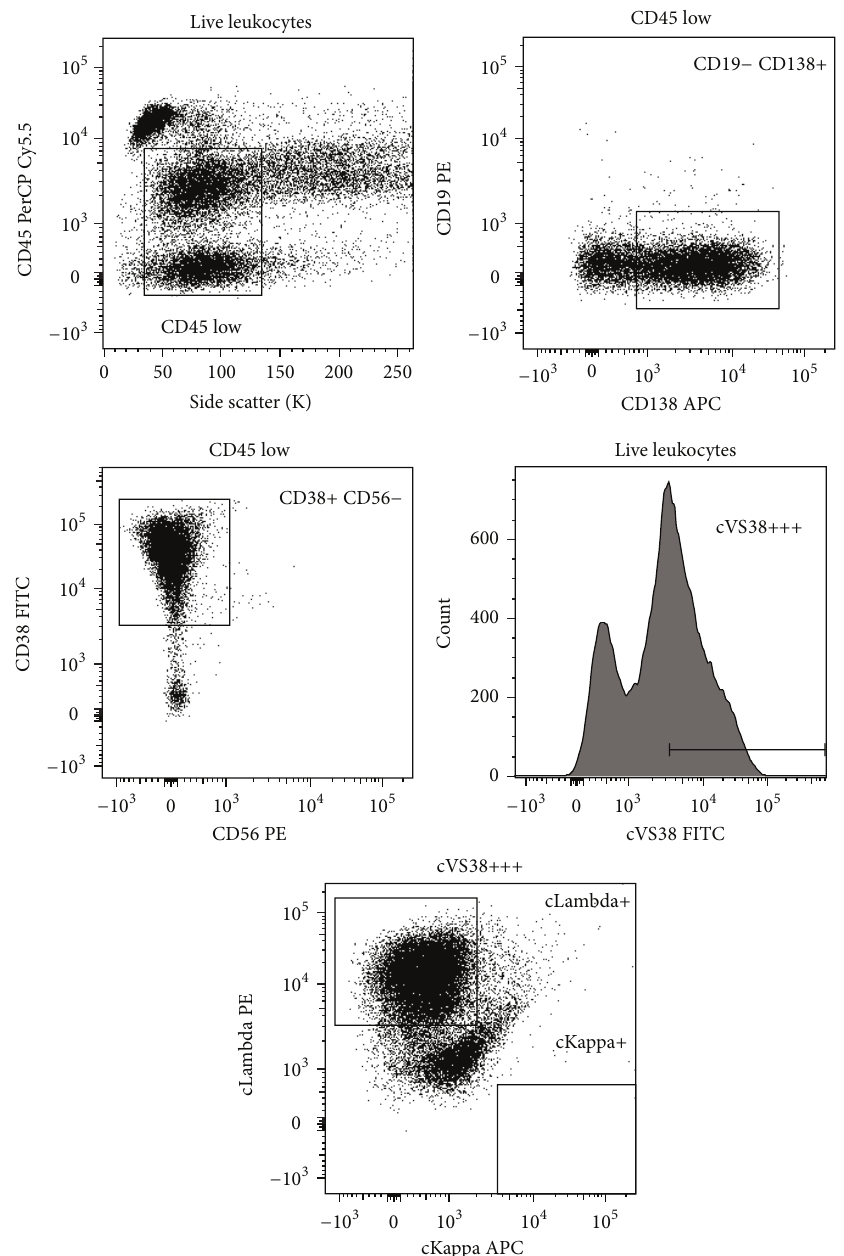
Figure 1: Flow cytometric data on peripheral blood at diagnosis, October 2008. The malignant clone is CD138+, CD38+, and CD56 − and displays lambda